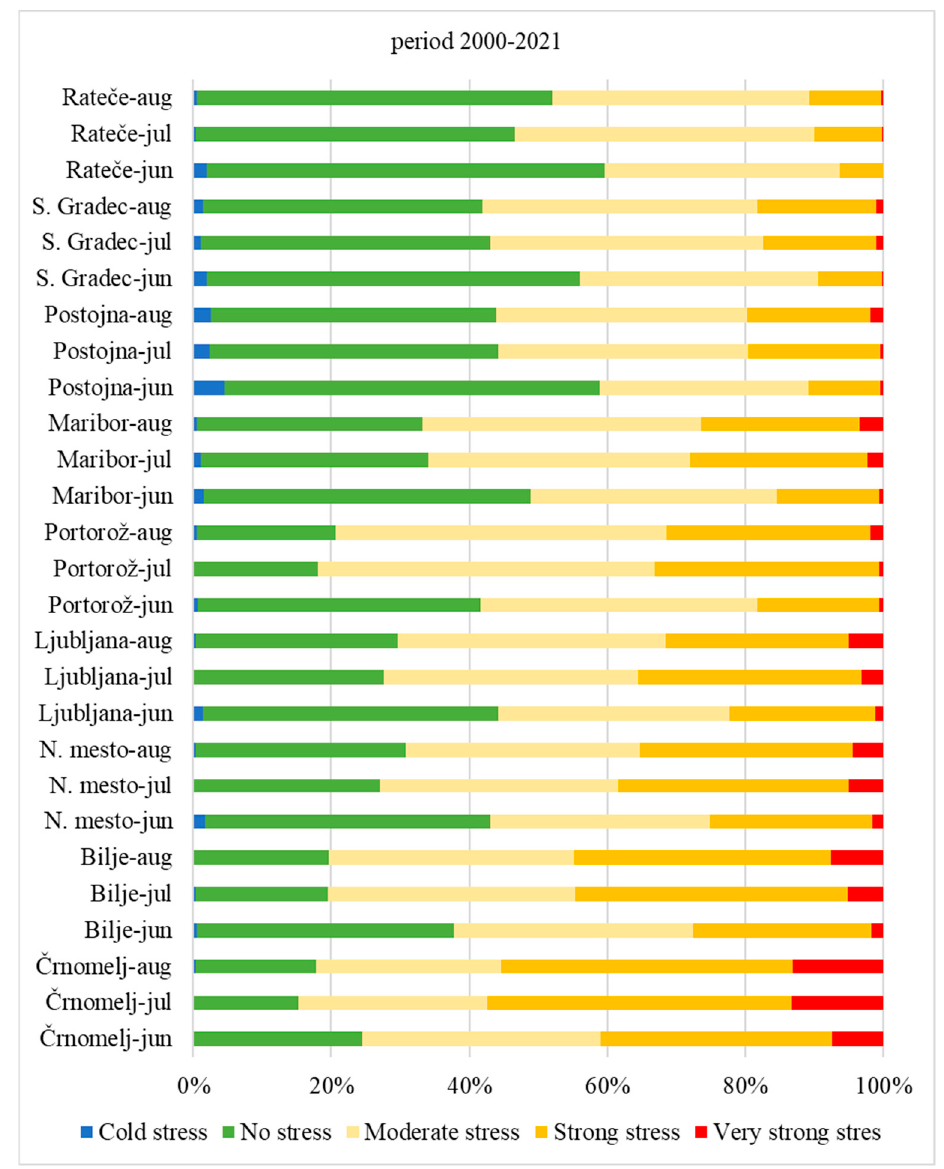
Figure 4. The percentage of days in each UTCI thermal stress class by summer month and station for the period 2000–2021.